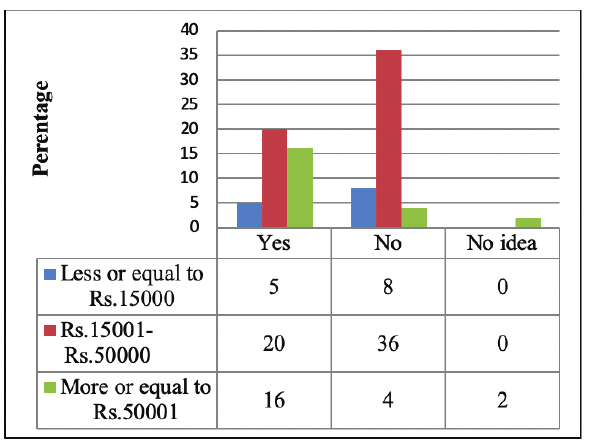
Figure 7: Crosstabulation between the income level of farmers and practice of an agritourism